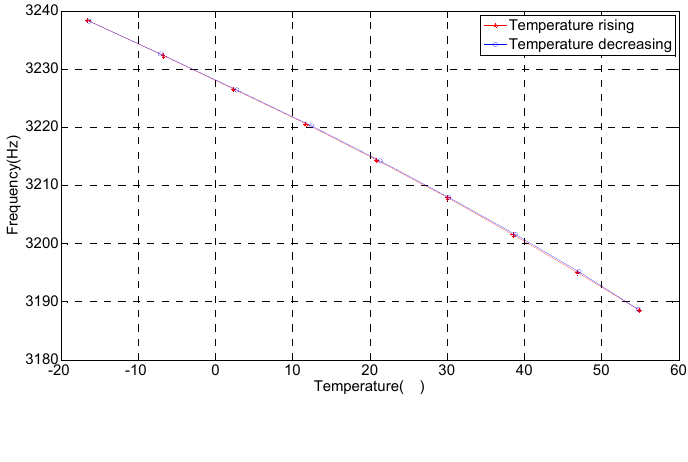
Figure 10. Natural frequency of the tuning fork changes with